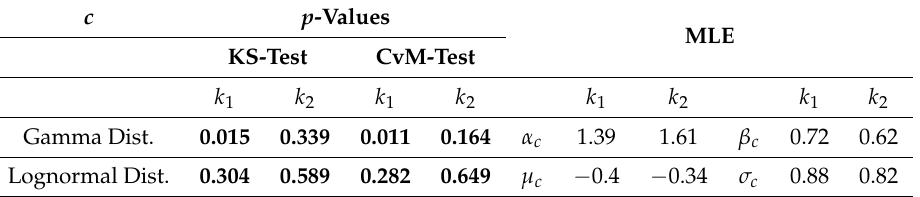
Table 2. Parameters and p -values for c .